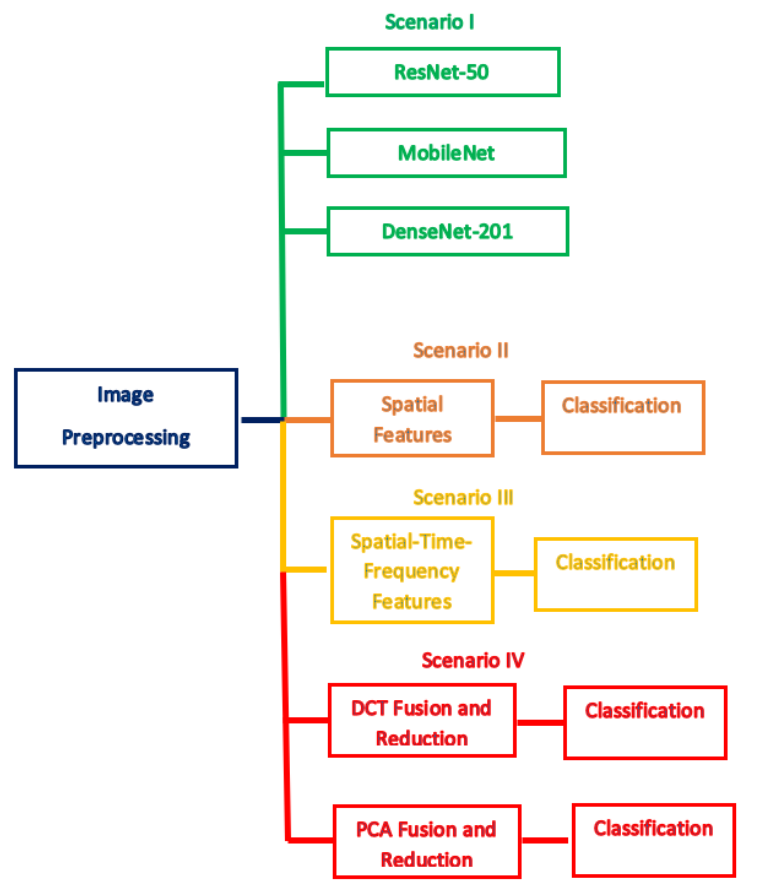
Figure 6. The four scenarios of MB-AI-His.